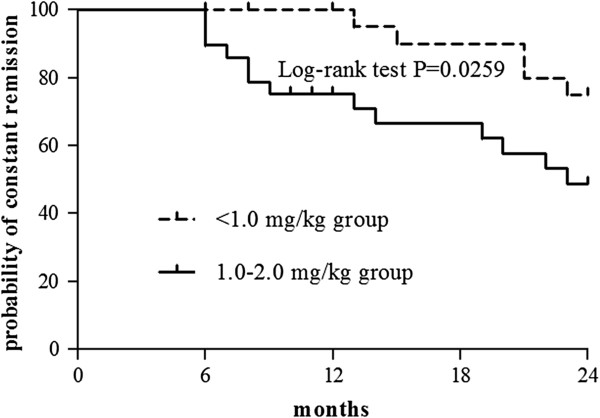
Cumulative probabilities of constant remission during 24 months using Kaplan-Meier statistical method.